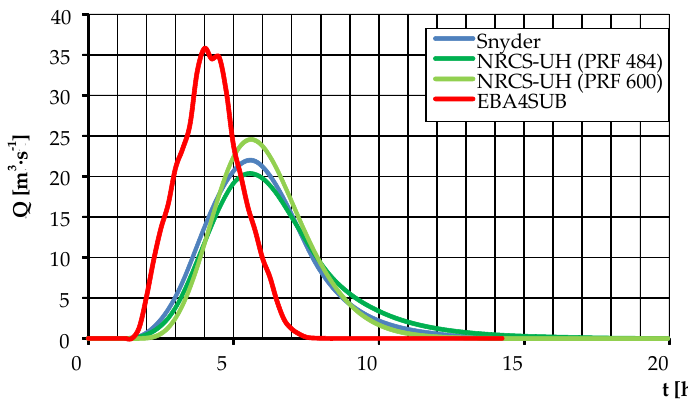
Figure 7. Design hydrograph for T = 10 years return period.